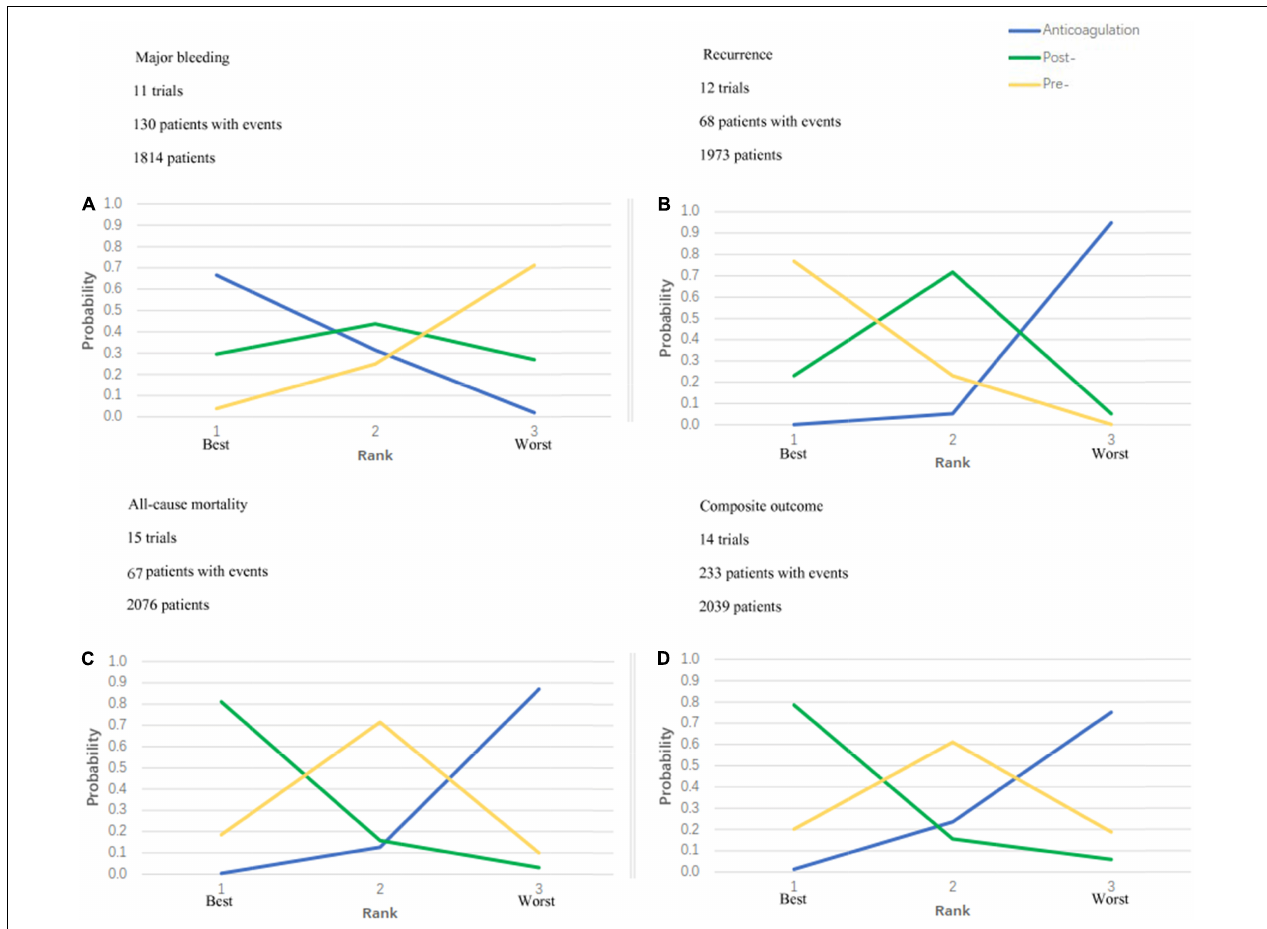
FIGURE 4 | Ranking plots. Strategy ranking plots for primary and secondary outcomes are stratified by treatment. (A) Is the ranking plot for major bleeding; (B) is the plot for recurrence; (C) is the plot for all-cause mortality and (D) is the plot for composite outcome. Each line represents 1 strategy and shows the probability of its ranking from best to worst. The peak of the line represents the rank that the strategy is most likely to be for each given outcome. For example, for all-cause mortality, post- thrombolytic anticoagulation is most likely to rank best; pre- thrombolytic anticoagulation, second best; and anticoagulation,